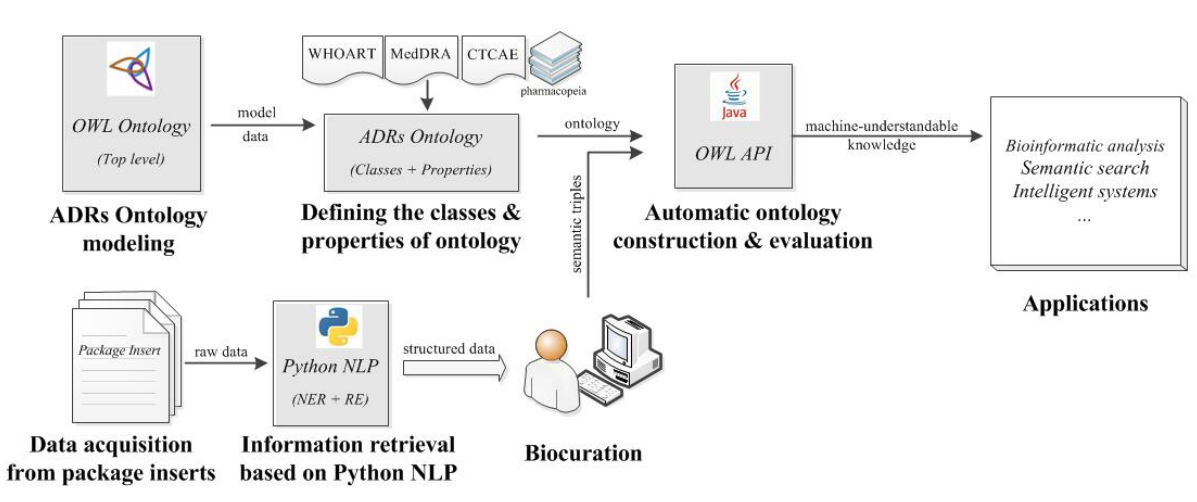
Figure 1. Study framework. ADRs: adverse drug reactions; API: application programming interface; CTCAE: Common Terminology Criteria for Adverse Events; MedDRA: Medical Dictionary for Regulatory Activities; NER: named entity recognition; NLP: natural language processing; OWL: Ontology Web Language; RE: relation extraction; WHOART: WHO Adverse Reactions